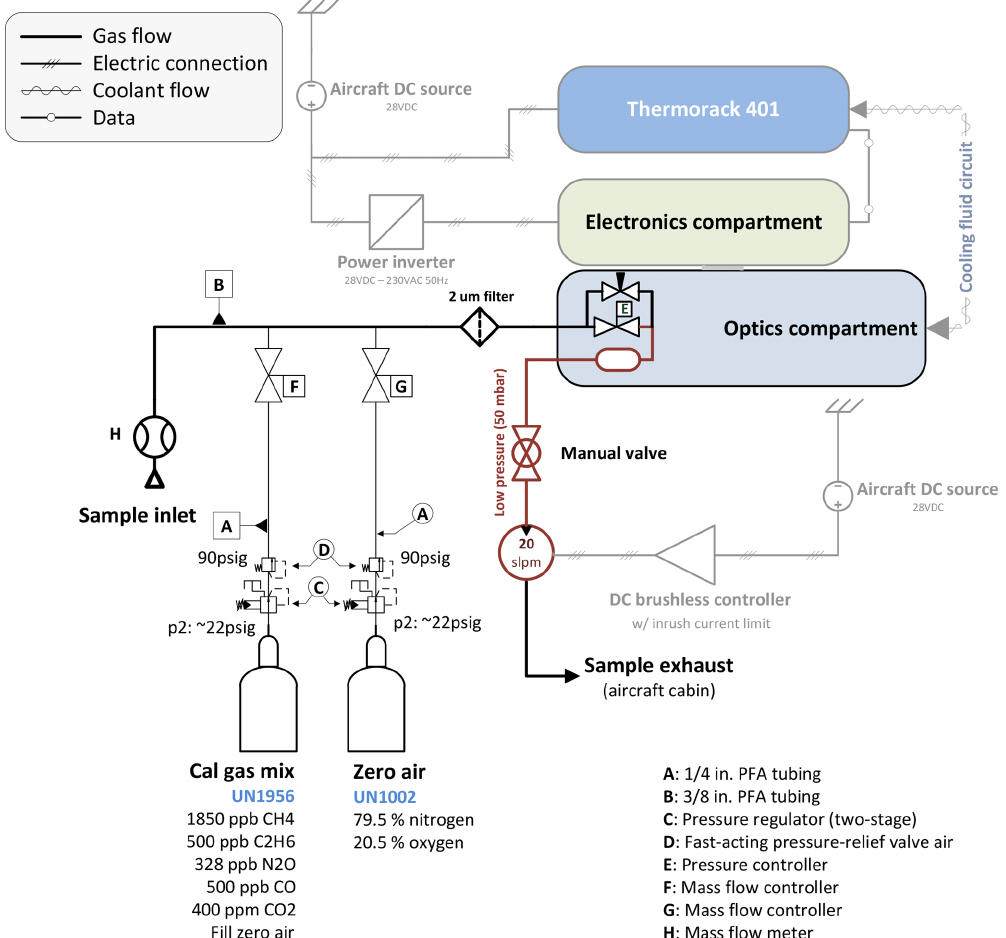
Figure 2. Schematic showing the main components with emphasis on the calibration system. A mass flow meter allows the sample flow rate to be measured. Two reference gases can be mixed at any arbitrary ratio by means of two calibrated mass flow controllers. A 2µm particle filter upstream of the sample cell avoids cell